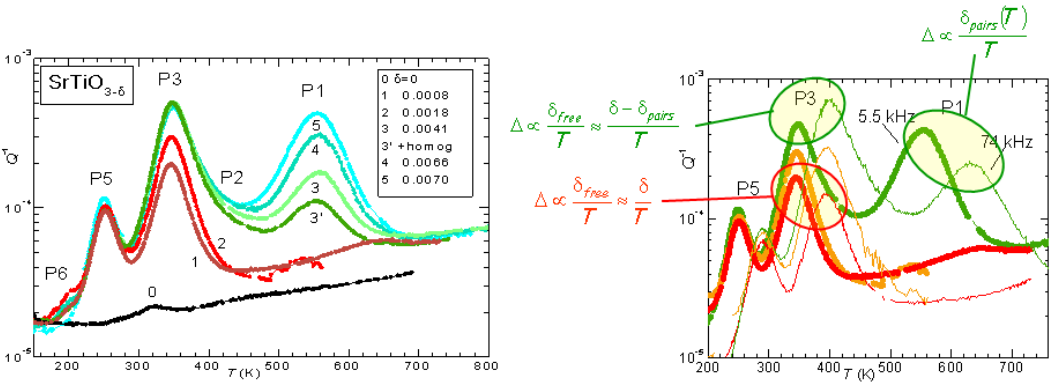
Figure 3. Elastic energy loss, Q − 1 , of single crystal SrTiO 3 − δ at various levels of O deficiency measured at 5.5 kHz. Right side: Q − 1 ( T ) curves measured at 5.5 and 74 kHz for δ = 0.0008,0.0018 and 0.0070. Adapted with permission from Ref. [26], copyrighted by the American Physical